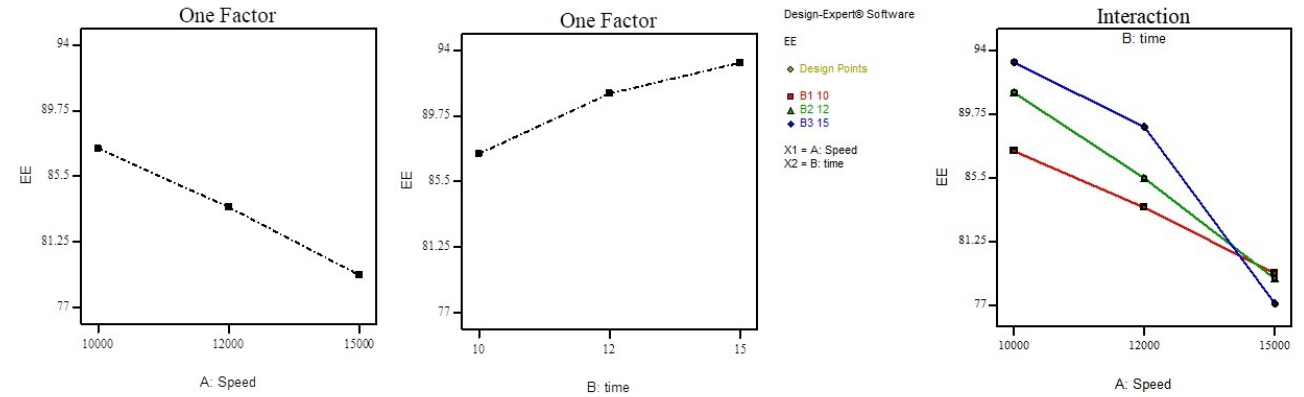
Figure 3. Effect of homogenization speed and time on the entrapping efficiency (EE).